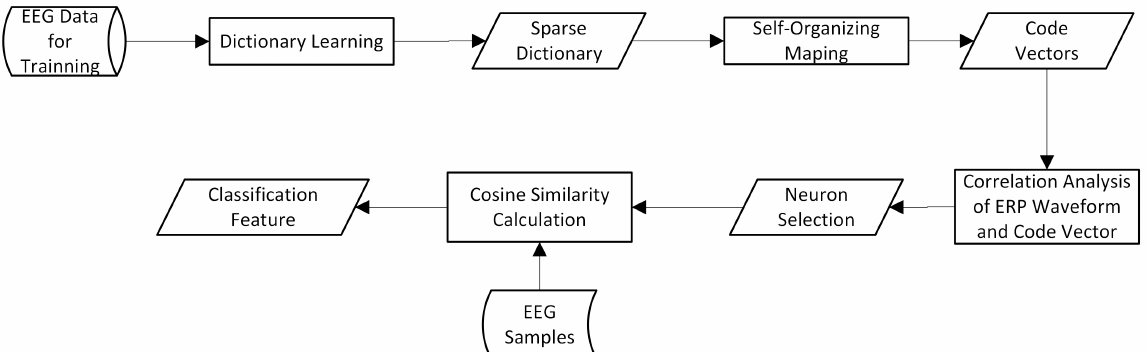
Figure 2. Flowchart of Feature Extraction Method.